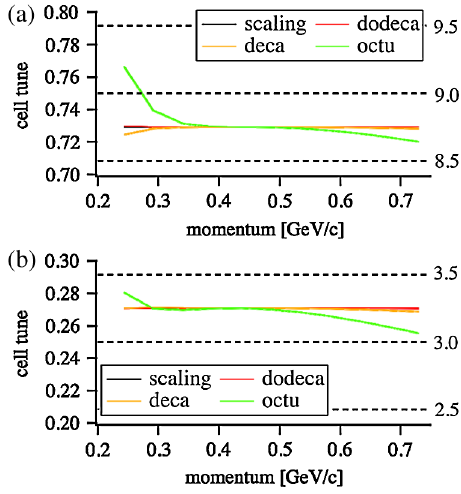
FIG. 5. Converting wedge-shaped magnets (dotted line) to rectangular magnets (solid line). The magnet center is un- changed and the three magnets face the machine